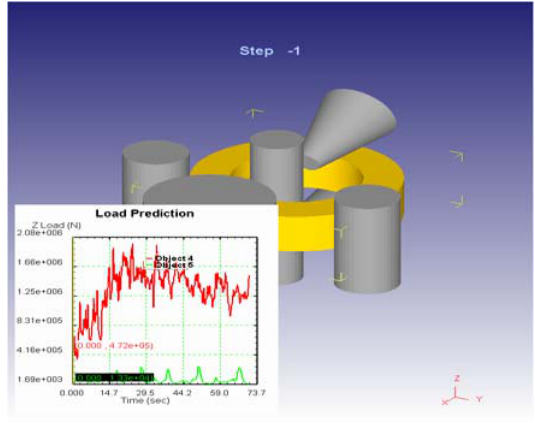
Fig. 4. The stress curve of upper cone roller